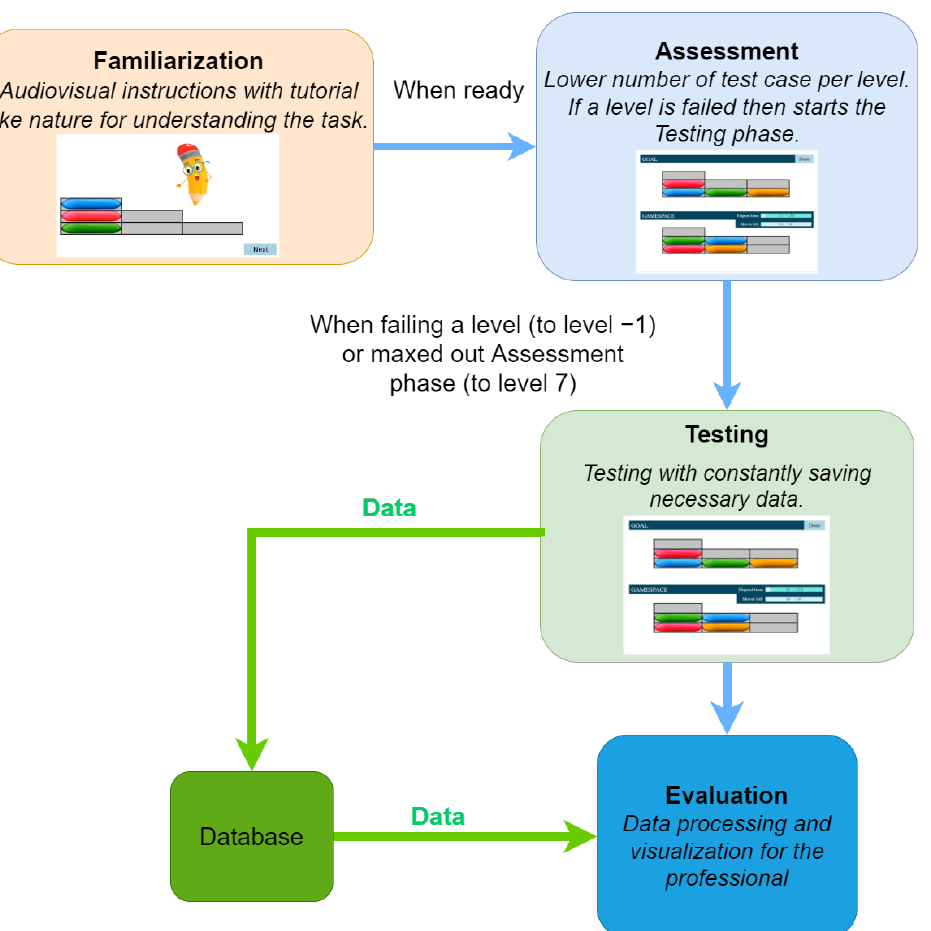
Figure 1. Overview of the system with the three phases